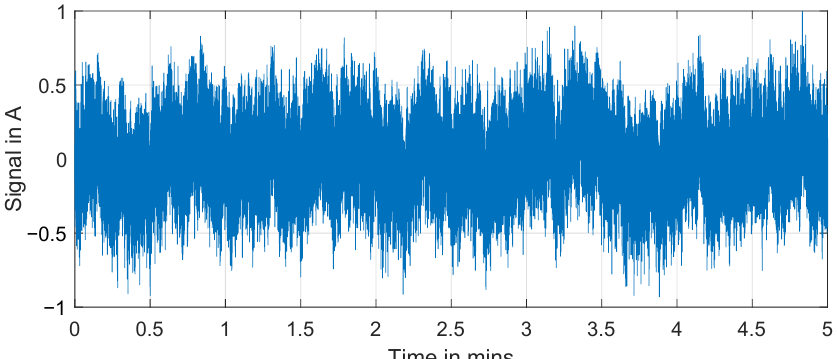
Figure 10. Time profile of the multisine signal optimized by the proposed solution for Lithium-ion